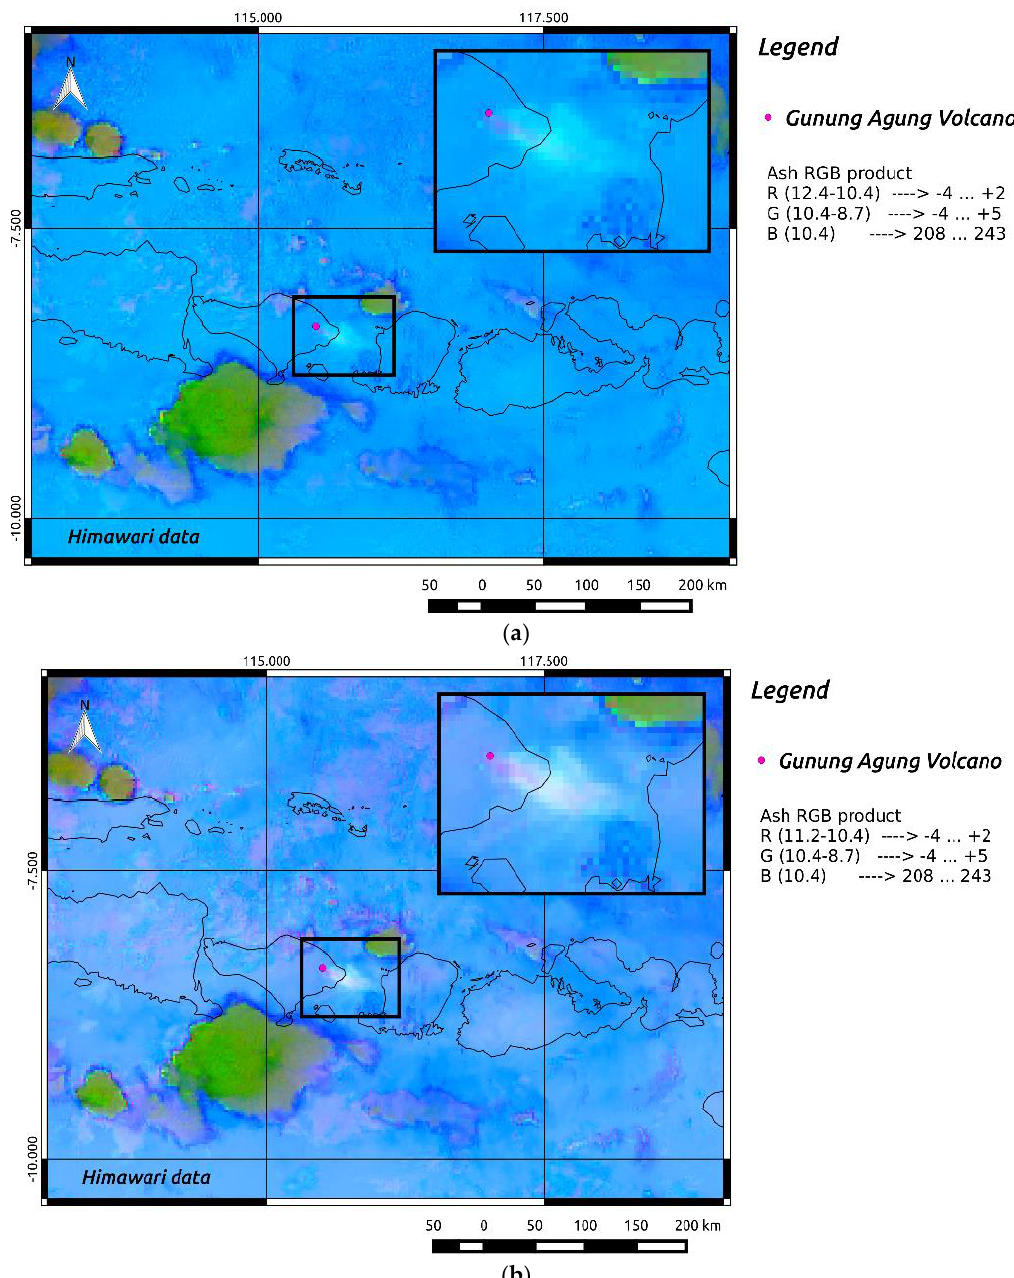
Figure 7. Ash RGB products from Himawari-8 data of 25 November at 22:00 UTC at 2 km spatial resolution; ( a ) Red = BT 12.4 − BT 10.4 , Green = BT 10.4 − BT 8.7 ; Blue = BT 10.4 ; Gamma: 1.0; ( b ) Red = BT 11.2 − BT 10.4 ; Green = BT 10.4 − BT 8.7 ; Blue = BT 10.4 ; Gamma: